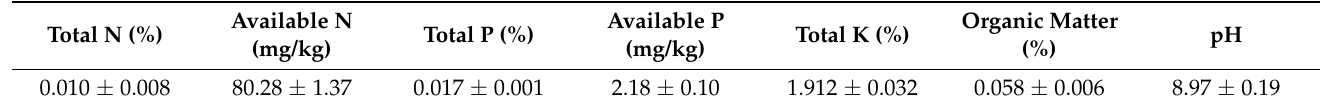
Table 1. The nutrients in the bare sand soil (0–10 cm layer) before sown A. sphaerocephala in 1996 of the test areas (average of 60